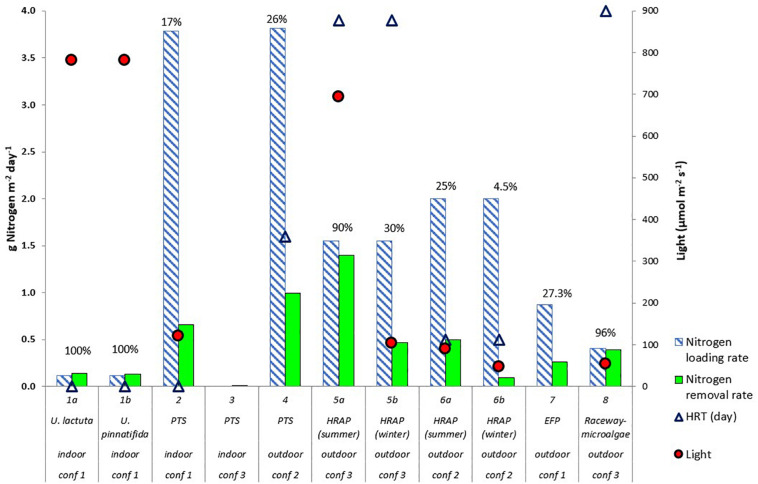
Nitrogen removal and loading rate (g Nitrogen m– 2 day– 1) by algal reactors in recirculating aquaculture systems (RAS).% value refers to the percentage of nitrogen removed. Maximum photosynthetic active radiation (light – μmol m– 2 s– 1) used in the studies are shown by red circles. Hydraulic retention time (HRT) (days) are shown by triangles (primary axis). For Study 3, HRT was not given, for Study 7, HRT was 60 days (not included in figure) The RAS configurations of Studies 1–8 are shown in Figure 4. Indoor and outdoor labels in the figure indicate the location of the algae reactors. The algae reactor in Study 1 used two algal species (Cahill et al., 2010), Ulva lactuca and Ulva pinnatifida. Study 2 (Valeta and Verdegem, 2015), Study 3 (Huang et al., 2013), and Study 4 (SustainAqua, 2009) used a periphyton turf scrubber (PTS). Study 5 (Pagand et al., 2000) and Study 6 (Deviller et al., 2004) used high-rate macroalgal based algal ponds (HRAP), and Study 7 (Gál et al., 2003) used an extensive fish pond (EFP). Study 8 (Li et al., 2019) used outdoor microalgal based raceway as methods to integrate algae in the RAS.